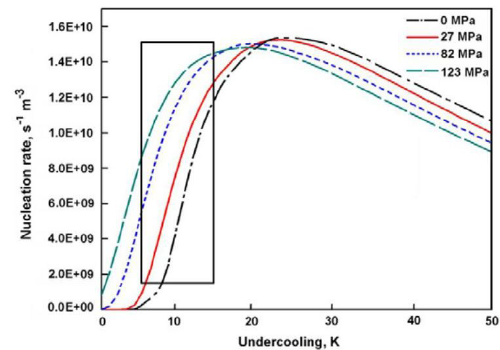
Figure 7. Influence of pressure on undercooling and nucleation rate of A356 aluminum alloy 11